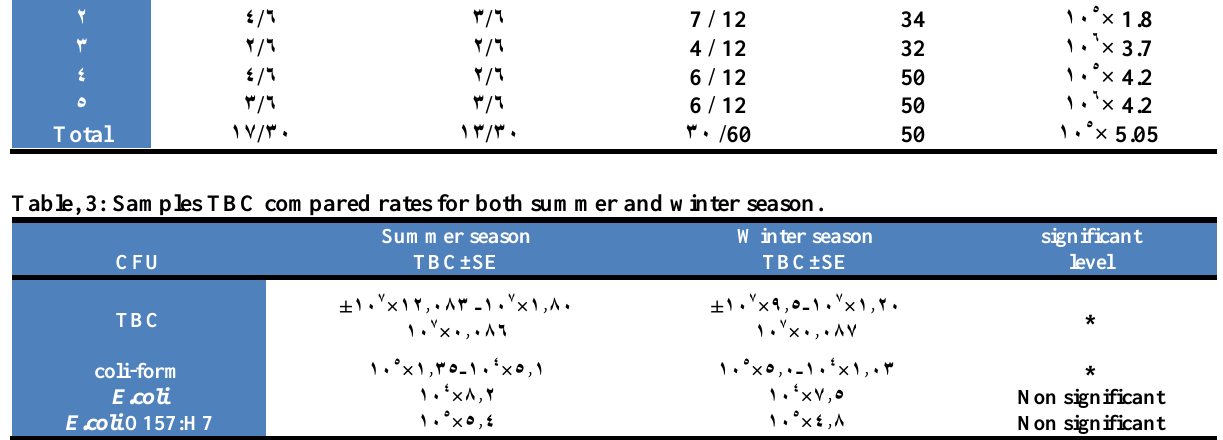
Table, 2: Isolation ratio and the rate of TBC of ( E.coli O157:H7/g) in stores popular areas. Popular areas